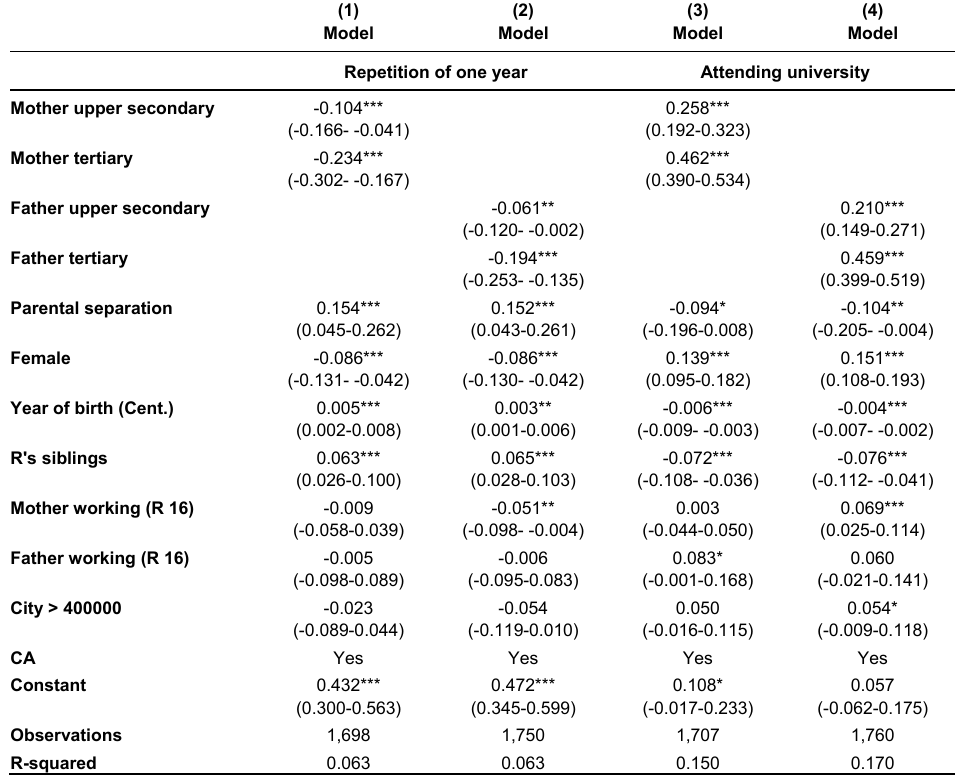
Table 3 : Linear Probability Models of repeating one year at school and attending university after parental separation by mother and father